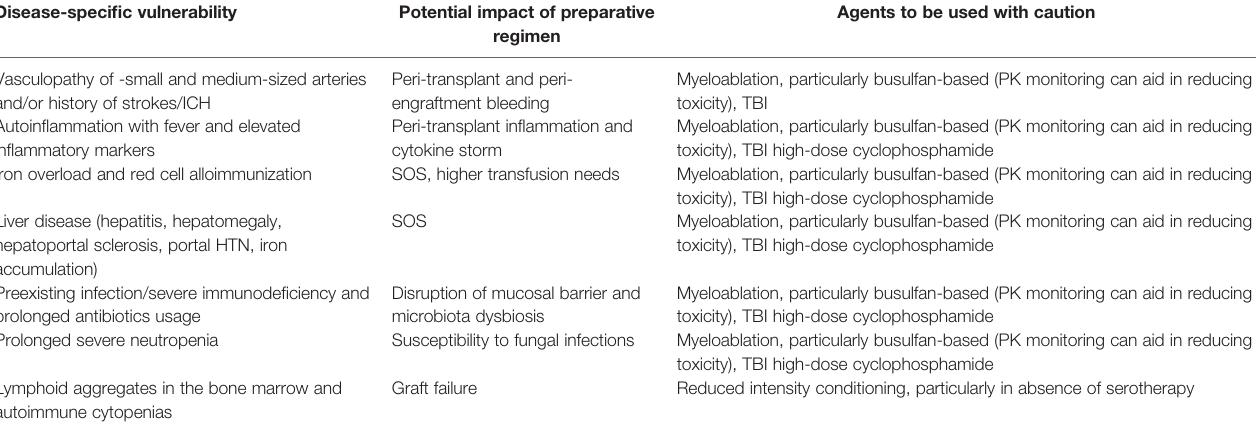
TABLE 2 | DADA2 speci fi c-disease vulnerabilities. Disease-speci fi c vulnerability